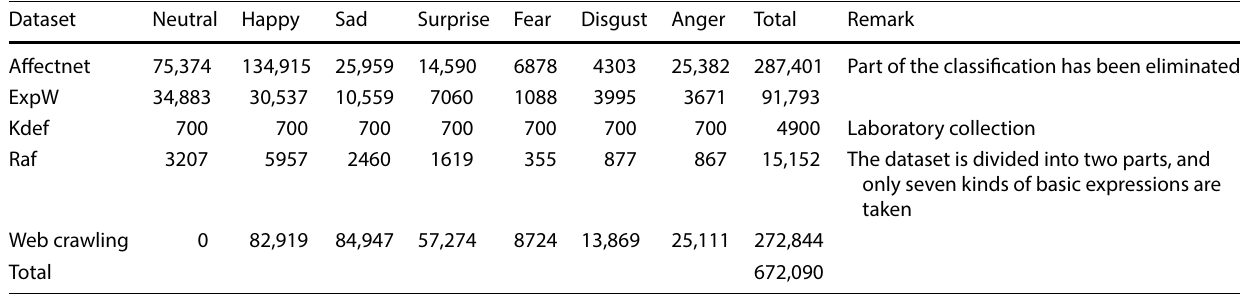
Table 1 Self-built facial expression dataset